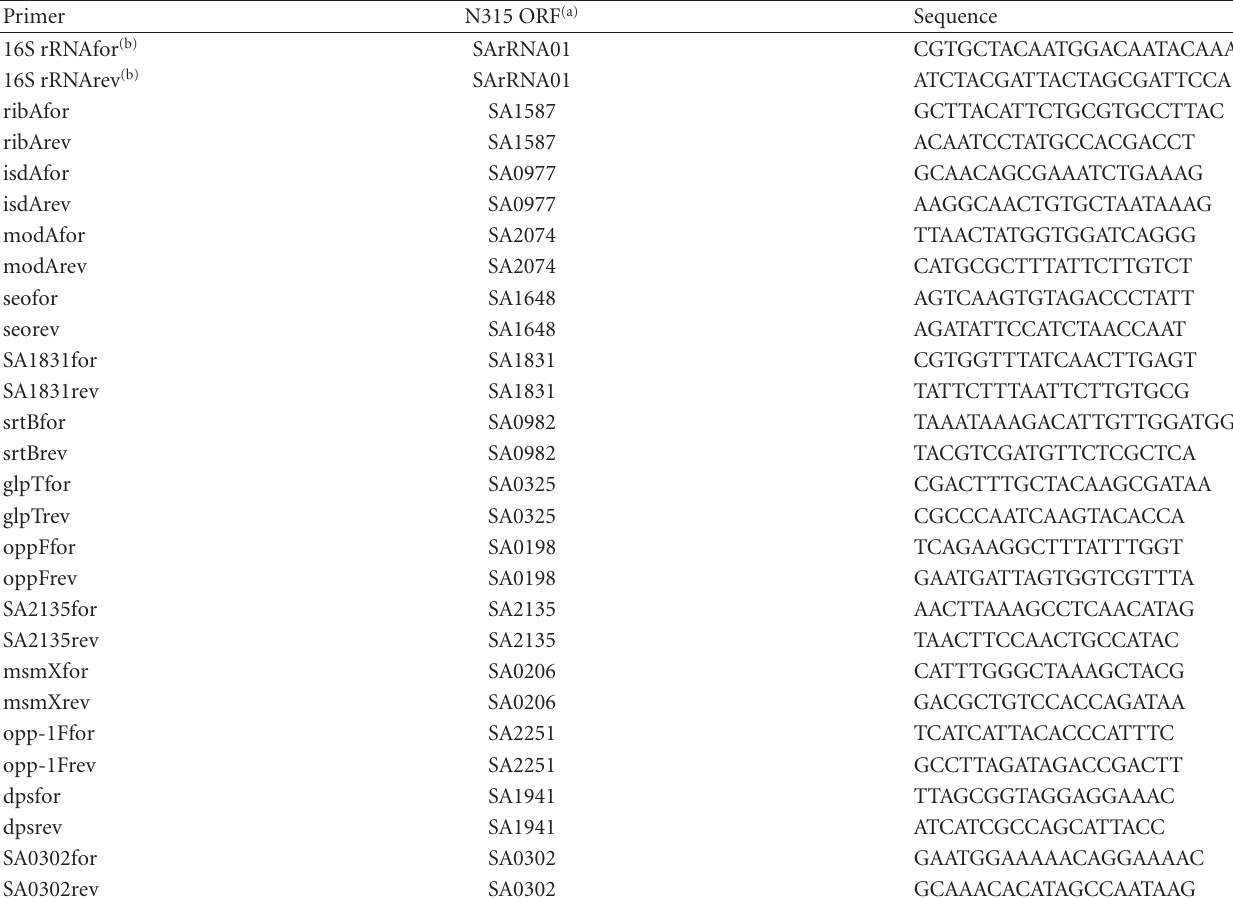
Table 2: Primers used in real-time RT-PCR with SYBR green